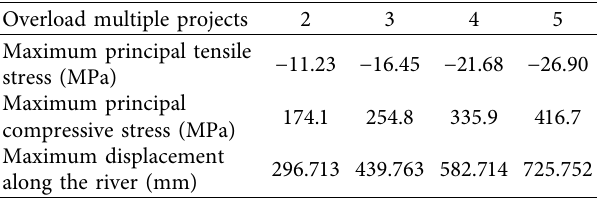
Figure 13: Maximum principal stress distribution of Xiluodu arch dam under overload condition (black dot indicates failure zone, unit: MPa). (a) Upstream (2 times normal water load). (b) Downstream (2 times normal water load). (c) Upstream (3 times normal water load). (d) Downstream (3 times normal water load). (e) Upstream (4 times normal water load). (f) Downstream (4 times normal water load). (g) Upstream (5 times normal water load. (h) Downstream (5 times normal water load). Table 9: Stress and displacement characteristics of the arch dam under overload